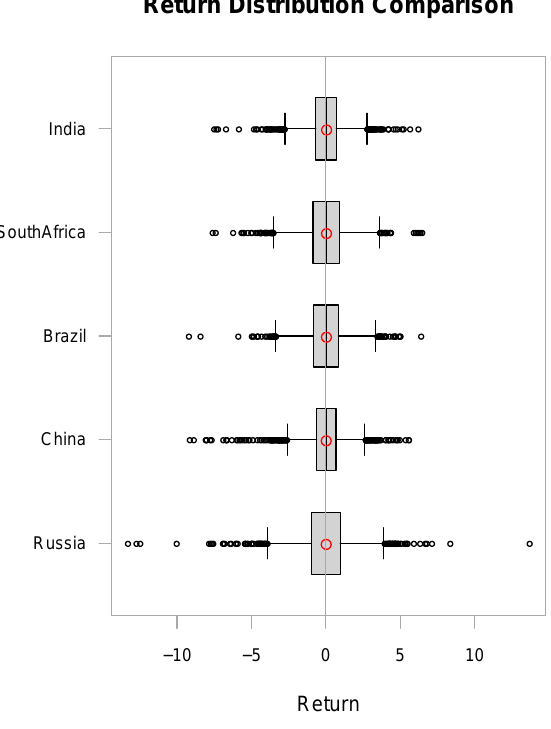
Figure A1. Box plots of the markets returns data.